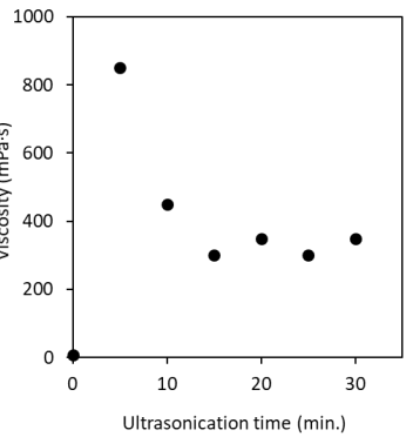
Figure 8. Viscosity of partially deacetylated chitin nanofiber suspension as a function of ultrasonication time.